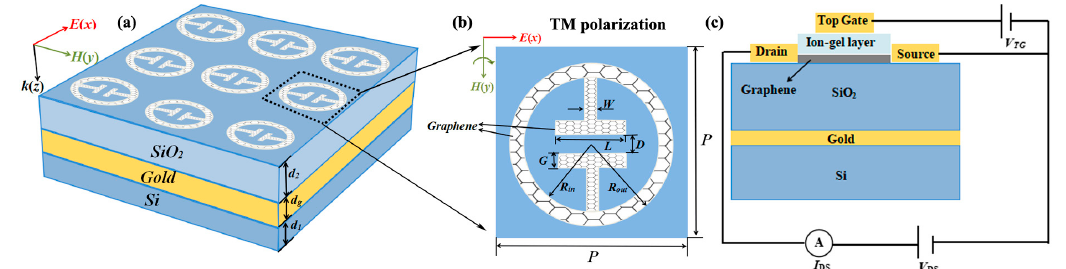
Figure 1. ( a ) Schematic of the perfect absorber structure; ( b ) the incident light polarization configuration (TM-polarization, TM-polarization indicates that the direction of the incident electric field is along the x axis); and ( c ) the schematic geometry of a top gate configuration to manipulate the Fermi energy of graphene. Parameters: d 1 = 3 µ m, d g = 0.45 µ m, d 2 = 4.17 µ m, t = 1 nm, R in = 0.8 µ m, R out = 1.05 µ m, D = 0.2 µ m, L = 0.7 µ m, G = 0.25 µ m, and W = 0.25 µ m. The periods in both x and y -directions